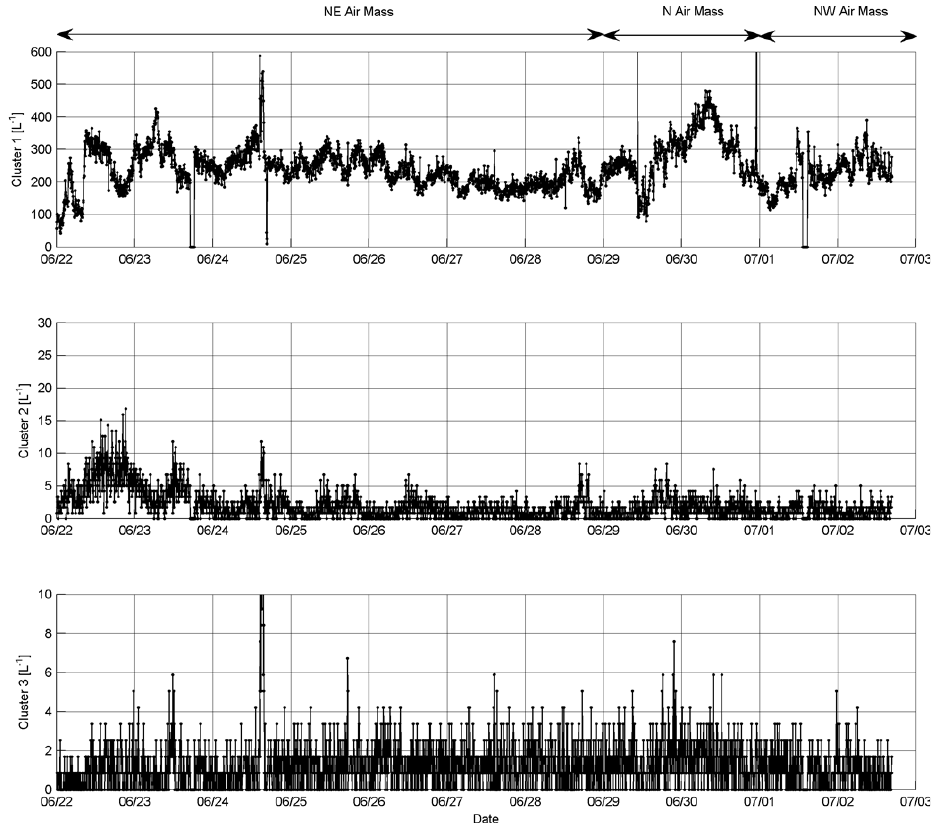
Fig. 7. Concentration time series of WIBS cluster analysis products with modelled air mass origin shown. Top to bottom show concentrations of clusters 1 to 3, respectively (L − 1 ).